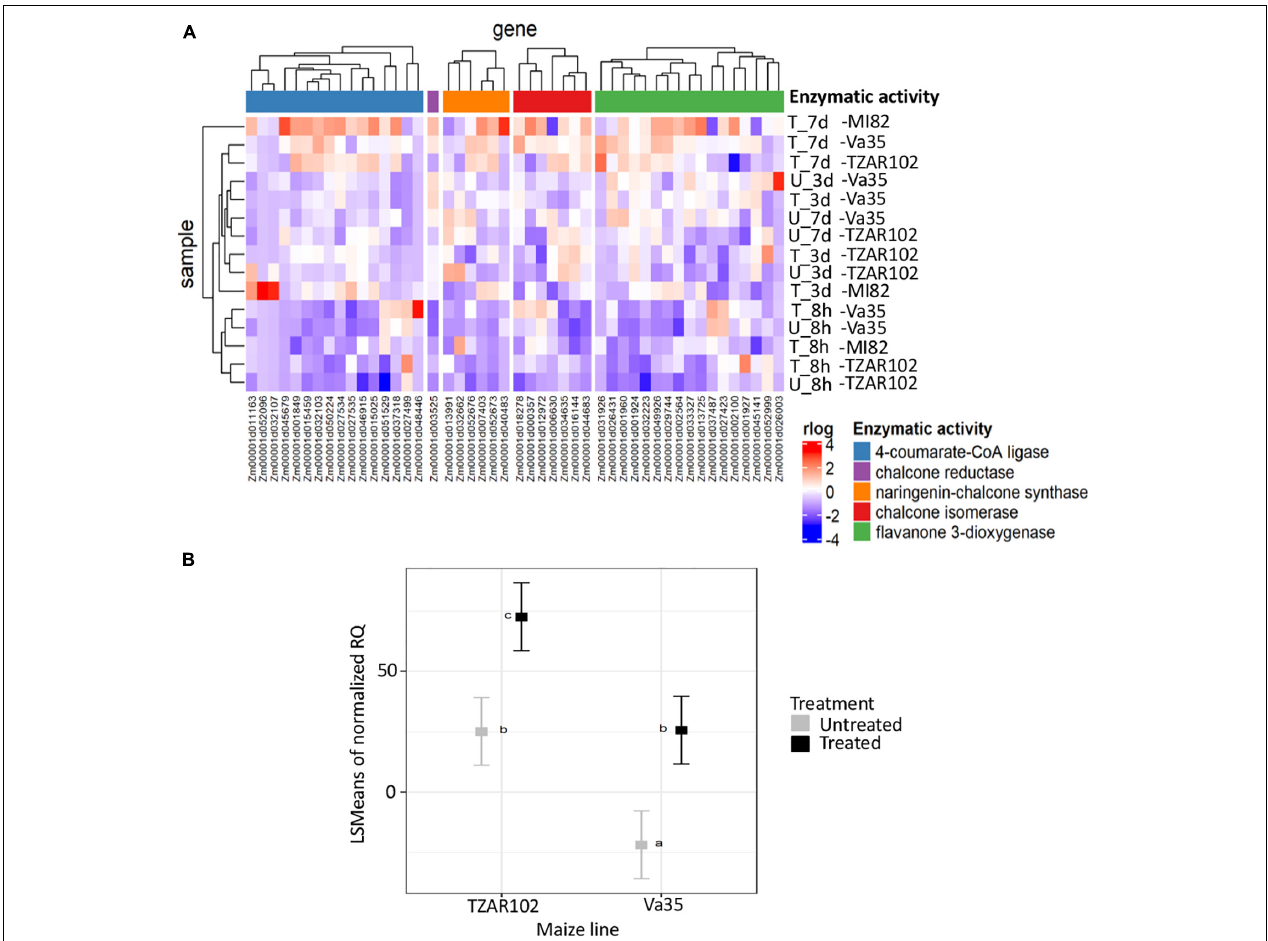
FIGURE 3 | Flavonoid pathway analysis. (A) Hierarchical clustering of gene expression patterns for flavonoids biosynthesis metabolic pathways detected in TZAR102 (R-Resistant), MI82 (R-Resistant) and Va35 (S-Susceptible). (B) Square root of the least-square means of gene expression of flavone synthase from in planta experiment. The heatmap was built using rlog of counts generated with DEseq2, flavonoid pathway from CornCyc with genes grouped according to their enzymatic activity. The colors in the heatmap represent the scaled rlog values. T, Treated, U, Untreated. Metabolic pathways are labeled with different colors, blue is 4-coumarate-CoA ligase, purple is chalcone reductase, orange is naringenin-chalcone synthase, red is chalcone isomerase and green is flavanone 3-dioxygenase. For gene expression, TZAR102 and Va35 are compared in treated and untreated environments by two-way ANOVA. Letters above square plots indicate the HSD-Tukey test results with P < 0.05. Error bars represent standard errors of